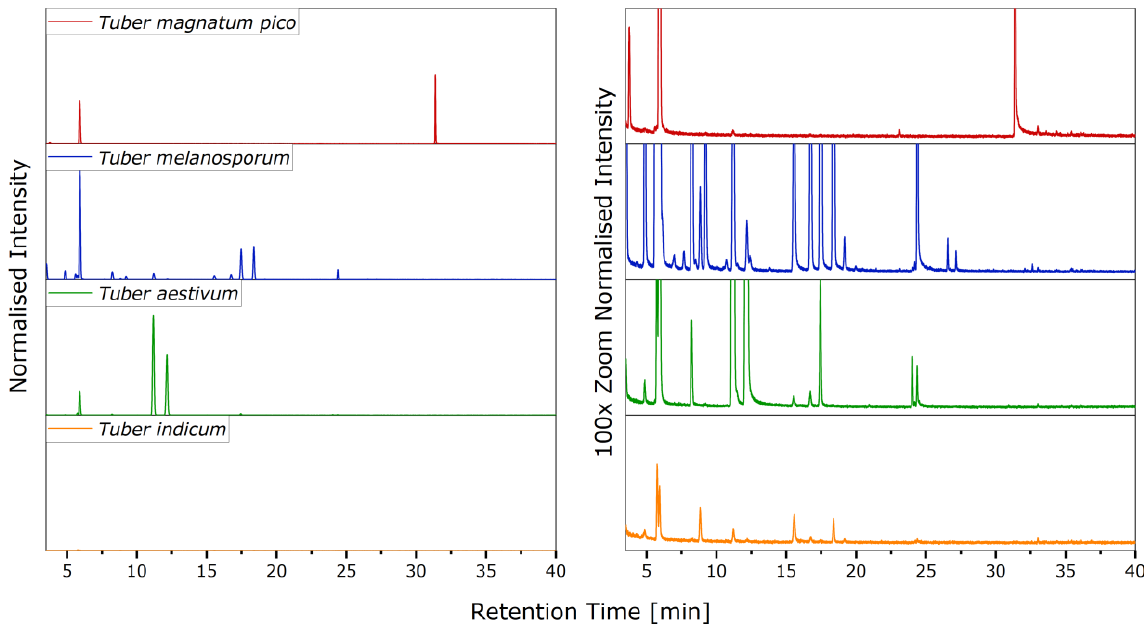
Figure 2. SHS/GC-MS total ion chromatograms of the examined truffles.